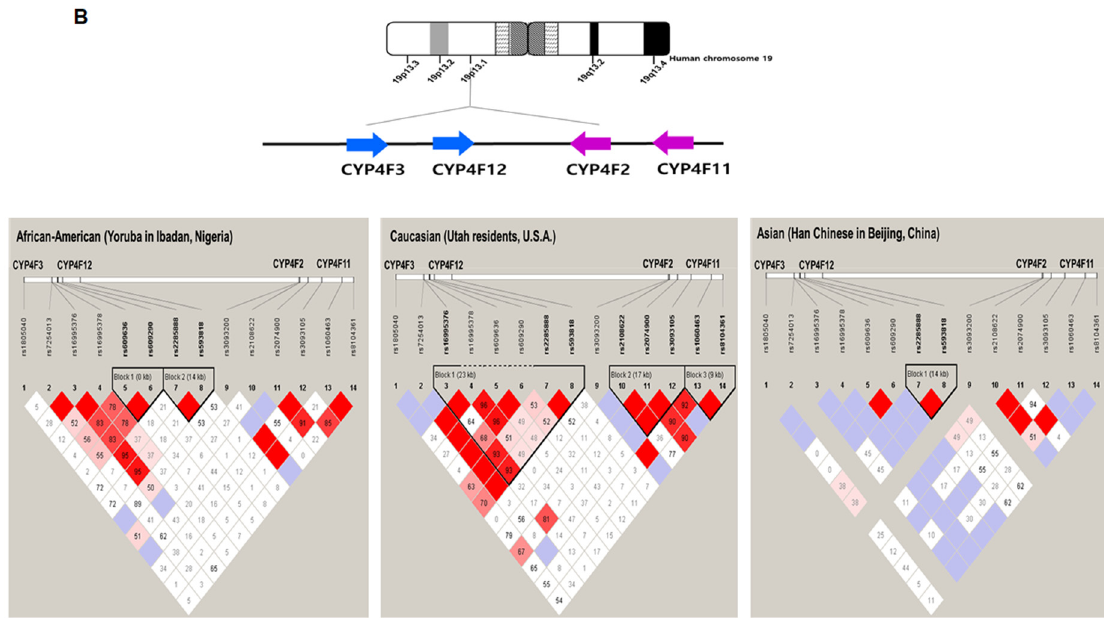
Figure 1. Linkage disequilibrium (LD) plots of CYP4 genetic variants in African, Caucasian, and Asian populations. Populations in Yoruba, Utah, and Beijing represent African, Caucasian, and Asian populations, respectively. The coding single nucleotide polymorphisms (SNPs) with a minor allele frequency (MAF) of 0.05 or greater in the 1000 genome data base were selected to avoid estimation errors in linkage analysis. ( A ) LD structures of CYP4A11 , CYP4A22 , and CYP4B1 with common coding SNPs. CYP4A11 , CYP4A22 , and CYP4B1 are clustered on chromosome 1. The SNPs, shown from left to right within the figure, are as follows: rs4646487, rs2297810, rs4646491, rs2297809, rs1126743, rs1126742, rs12564525, rs2056900, rs2056899, rs113777592, rs10789501, rs149718343, rs2405599, and rs4926600. ( B ) LD structures of CYP4F2 , CYP4F3 , CYP4F11 , and CYP4F12 using common coding SNPs. CYP4F2 , CYP4F3 , CYP4F11 , and CYP4F12 are clustered on chromosome 19. The SNPs, shown from left to right within the figure, are as follows: rs1805040, rs7254013, rs16995376, rs16995378, rs609636, rs609290, rs2285888, rs593818, rs3093200, rs2108622, rs2074900, rs3093105, rs1060463, and rs8104361. The numbers in squares refer to pairwise LD values, measured as D’ (coefficient of linkage disequilibrium). Red depicts a significant linkage between a pair of SNPs. Numbers inside squares indicate the D’ value multiplied by 100.